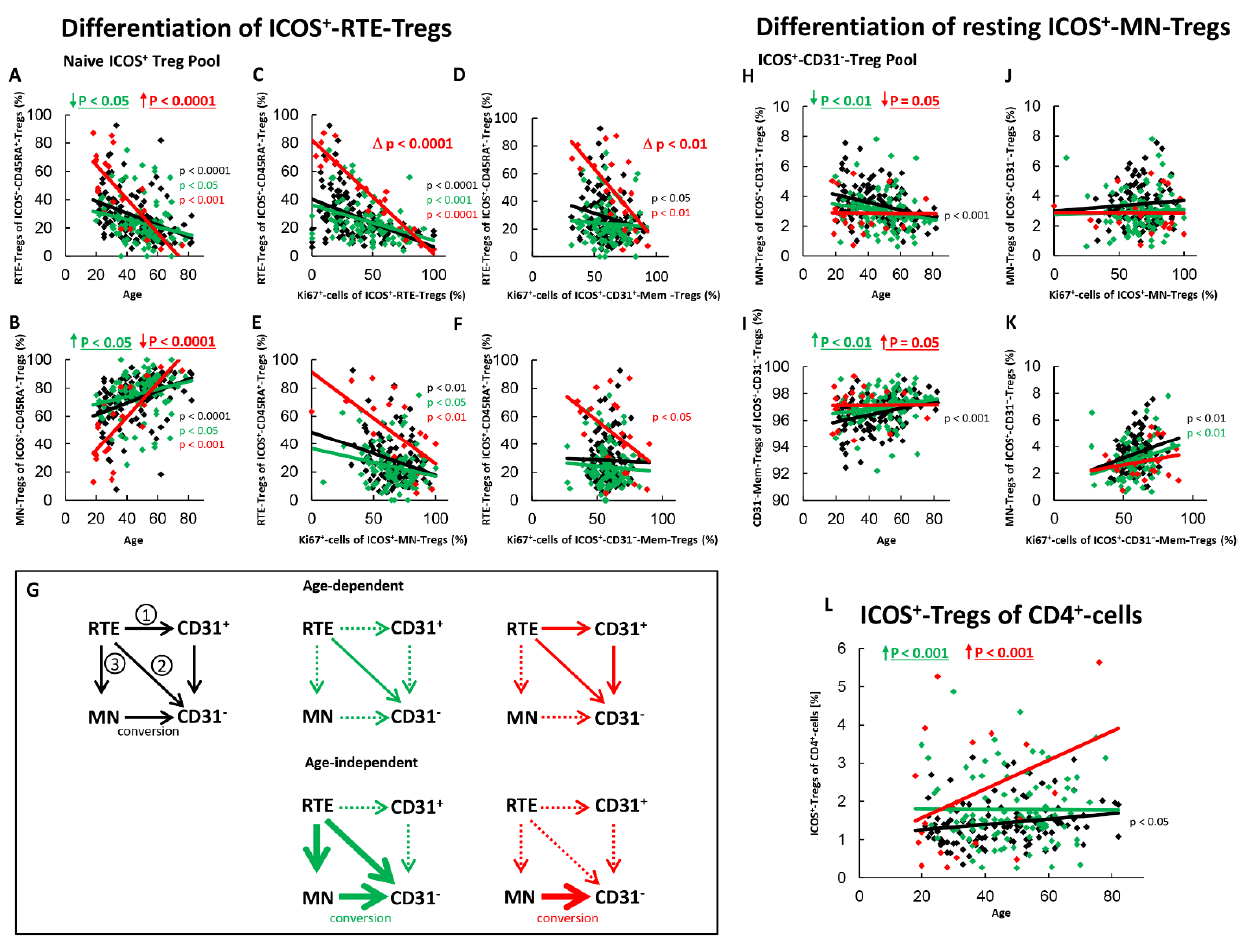
Figure 2. Differentiation of ICOS + -RTE-Tregs and resting ICOS + -MN-Tregs with age in healthy controls, SLE patients in remission and SLE patients with active disease. The percentages of RTE-Tregs and MN-Tregs within the naïve ICOS + - CD45RA + -Treg pool ( A , B ) as well as the percentages of MN-Tregs and CD31 − -memory Tregs within the ICOS + -CD31 − - Treg pool ( H , I ) were estimated depending on age in healthy volunteers (Black coloured), SLE patients in remission (Green coloured) and SLE patients with active disease (Red coloured). In order to examine the differentiation of ICOS + -RTE- Tregs, the percentage of RTE-Tregs within total naïve CD45RA + -Tregs was correlated with the percentage of Ki67 + cells within total RTE-Tregs ( C ), CD31 + -memory-Tregs ( D ), MN-Tregs ( E ) and CD31 − -memory-Tregs ( F ). In order to examine the differentiation of resting MN-Tregs, the percentage of MN-Tregs within total CD31 − -Tregs was correlated with the percentage of Ki67 + cells within total MN-Tregs ( J ) and within total CD31 − -memory-Tregs ( K ). Significant linear regression analyses are marked by black, green, or red P-values. Significant differences in the regression lines between healthy controls and SLE patients in remission or active disease are marked by green or red ∆ p values. Age-independent significant differences between healthy volunteers and study groups are marked by an arrow ( ↑↓ ) and their color-matched P-values. The arrow diagrams ( G ) schematize an increased (thick arrow), consistent (thin arrow) or decreased (dashed arrow) differentiation, color matched for the different patient groups. The resulting age-dependent and age-independent changes in the percentage of ICOS + -Tregs within total CD4 + -T-helper cells are given in ( L ). Further information of the calculated P-values is illustrated in Table